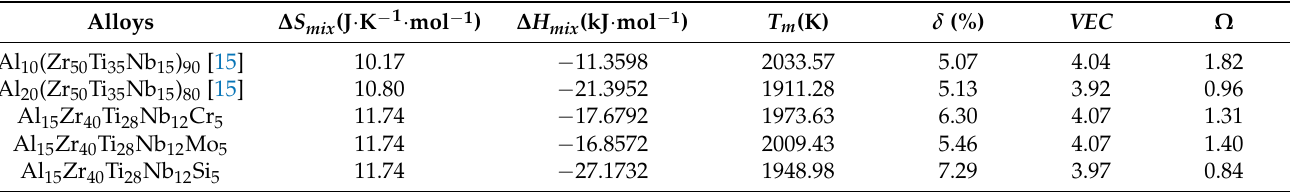
Table 3. The calculated parameters for the phase formation of the Al 15 Zr 40 Ti 28 Nb 12 M 5 (Cr, Mo, Si) and Al x (Zr 50 Ti 35 Nb 15 ) 100 − x [15]